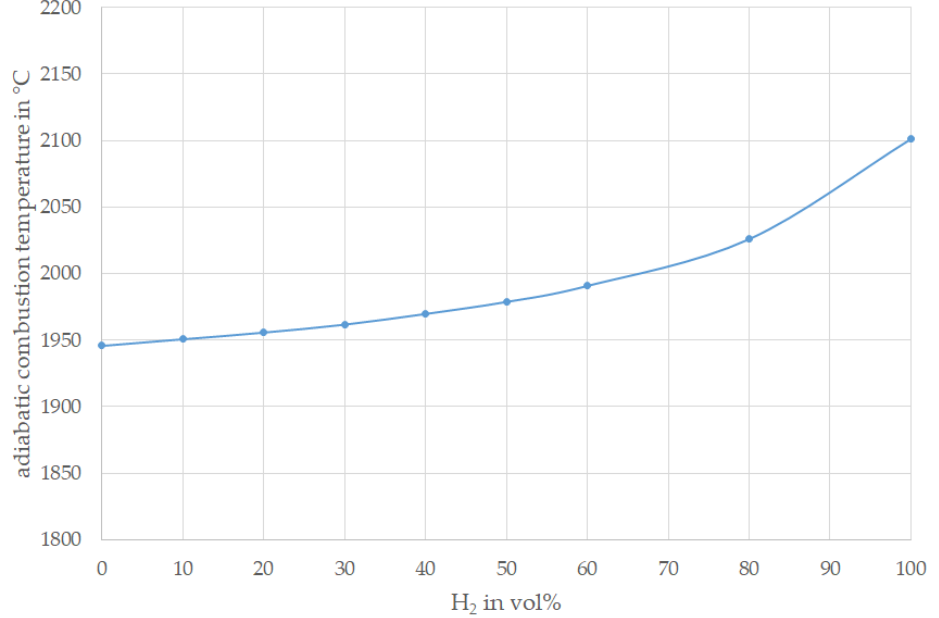
Figure 3. Adiabatic combustion temperature of CH 4 /H 2 blends at stoichiometric conditions ( p = 1.01325 bar).